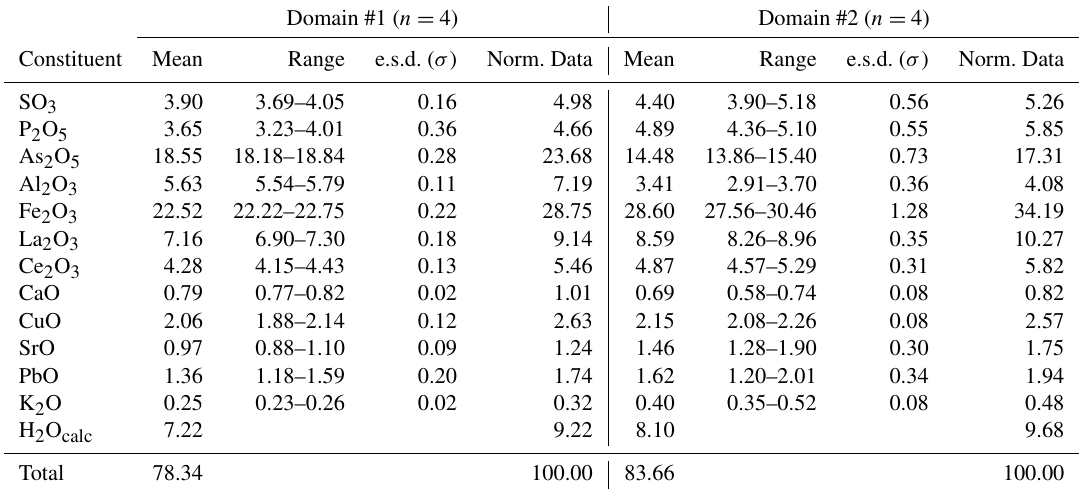
Table 1. Chemical data (in wt%) for graulichite-(La).